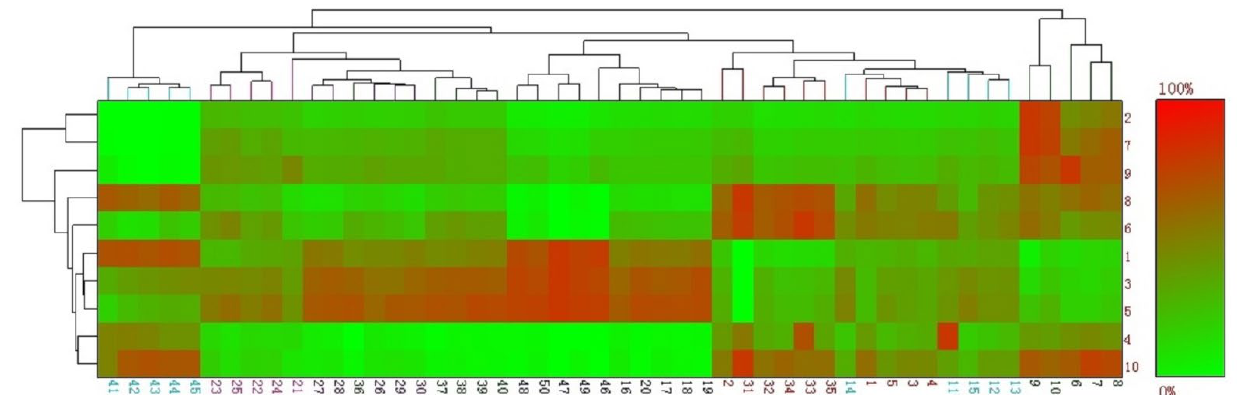
Figure 4. Cluster analysis heat map of E-nose (number on vertical axis correspond to those in Table 1, number on horizontal axis each five connected numbers correspond to a group, numbers 1–5 correspond to the five parallels of group A1, and so